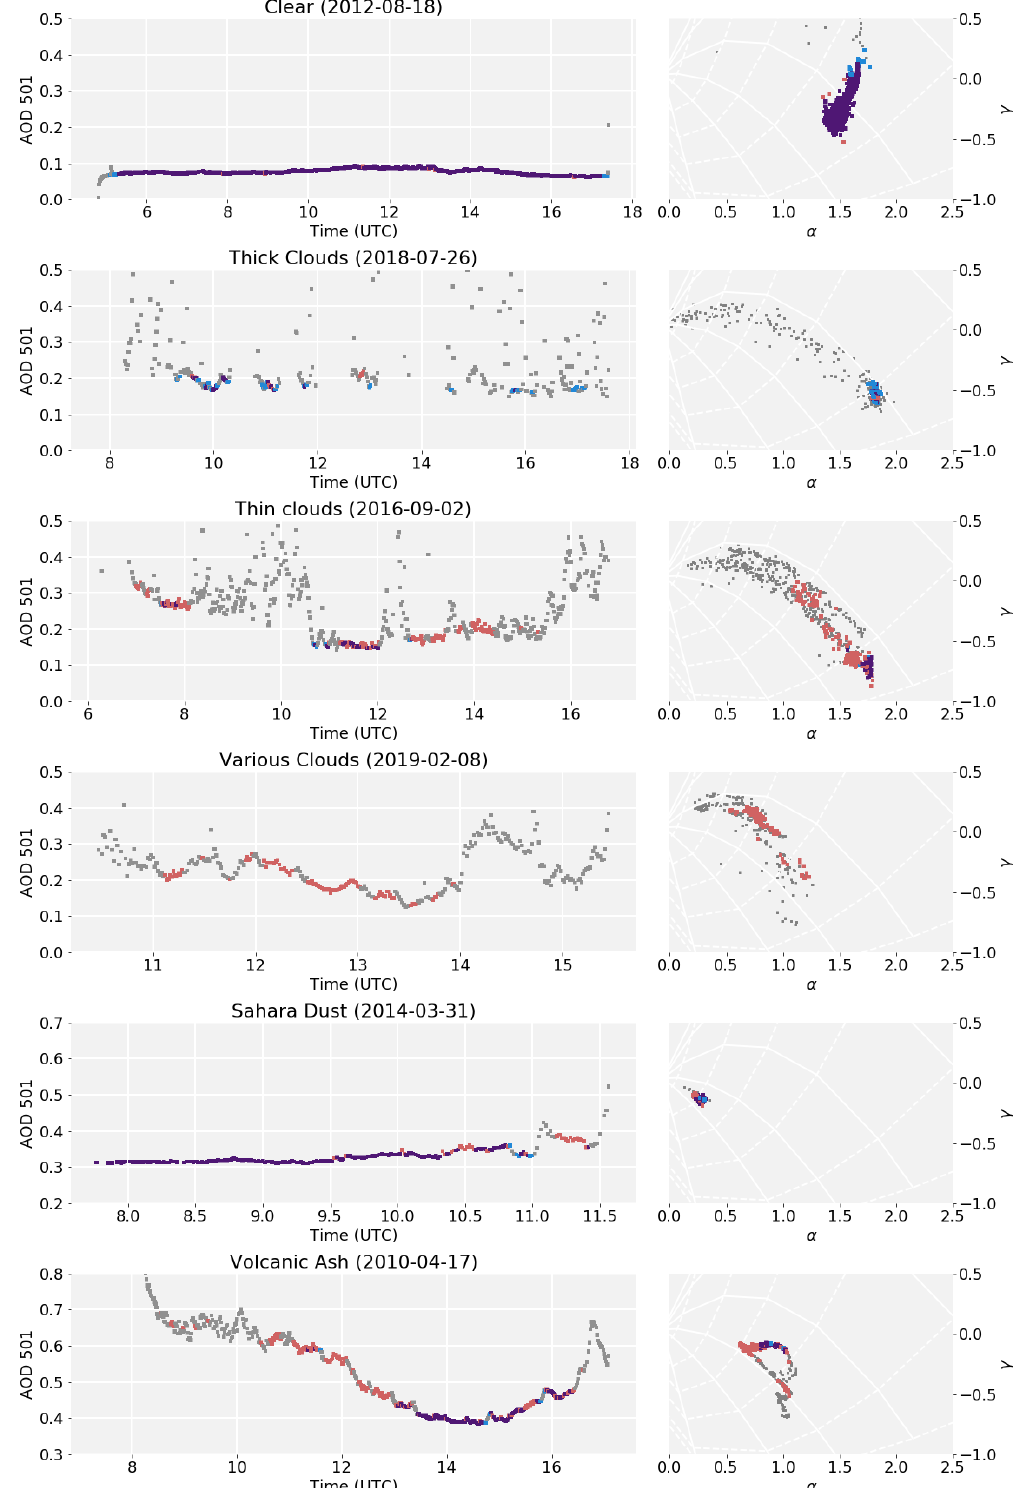
Figure 4. Comparison of cloud flagging routines on selected days with different cloud conditions as signified in the respective title. Colours are as in Fig. 3. Left: time series of AOD at 501nm, Right: α – γ plots. The solid white lines show different particle radii, and the dotted white lines show different fine mode fractions; grid adapted from Gobbi et al. (2007). Note the different x axis scales for the time